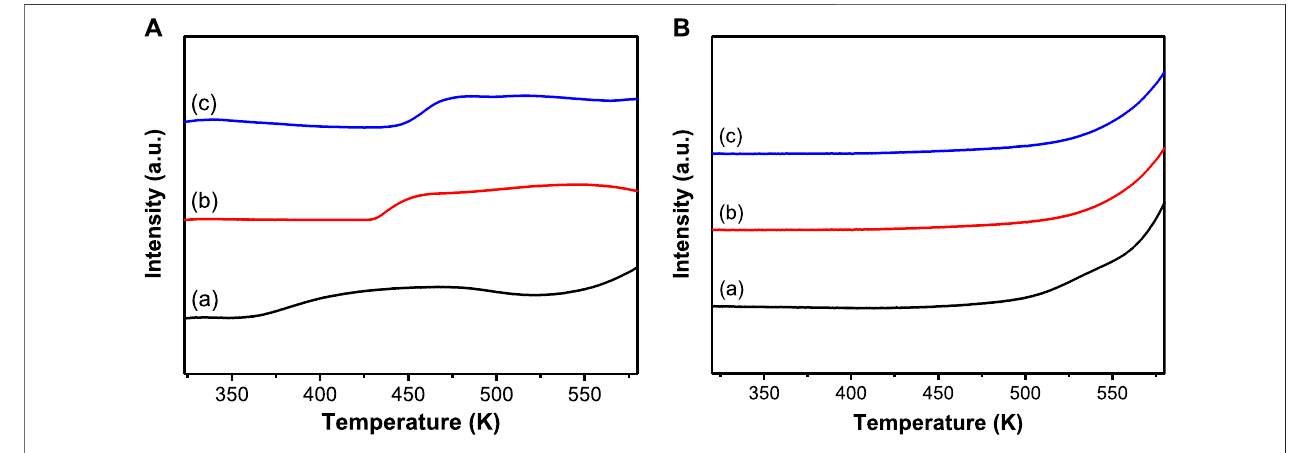
Frontiers in Chemical Engineering |